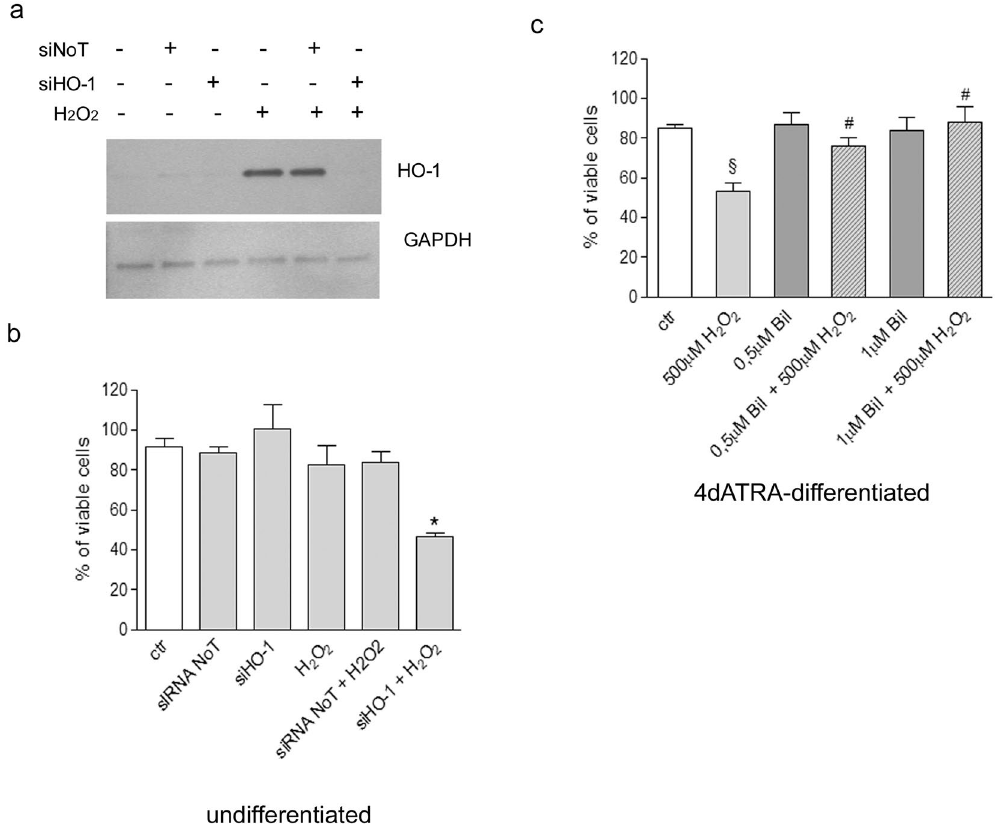
Figure 4. HO-1 expression is responsible for undifferentiated cell resistance to oxidative stress. Bilirubin supplementation restores viability in differentiated cells exposed to H 2 O 2 . ( a ) WB analysis of HO-1 in undifferentiated cells exposed for 24 h to 500 μ M H 2 O 2 and silenced for HO-1. GAPDH expression have been used as loading control. The bands show one representative experiment of three. ( b ) % of viability in undifferentiated cells exposed for 24 h to 500 μ M H 2 O 2 and silenced for HO-1. Some samples have been treated with a scramble siRNA (siNoT) to exclude aspecific cell responses. Statistical analysis: n = 3, * p < 0.05 vs H 2 O 2 . ( c ) 4d-ATRA differentiated cells, have been co-treated with 500 μ M H 2 O 2 and bilirubin (0.5 µ M or 1 µ M) in order to prevent cell death induced by cell exposure to H 2 O 2 alone. The % of viable cells is shown. Statistical analysis: n = 3, § p < 0.01 vs ctr; # p < 0.05 vs H 2 O 2 . Full-length blots are presented in supplementary